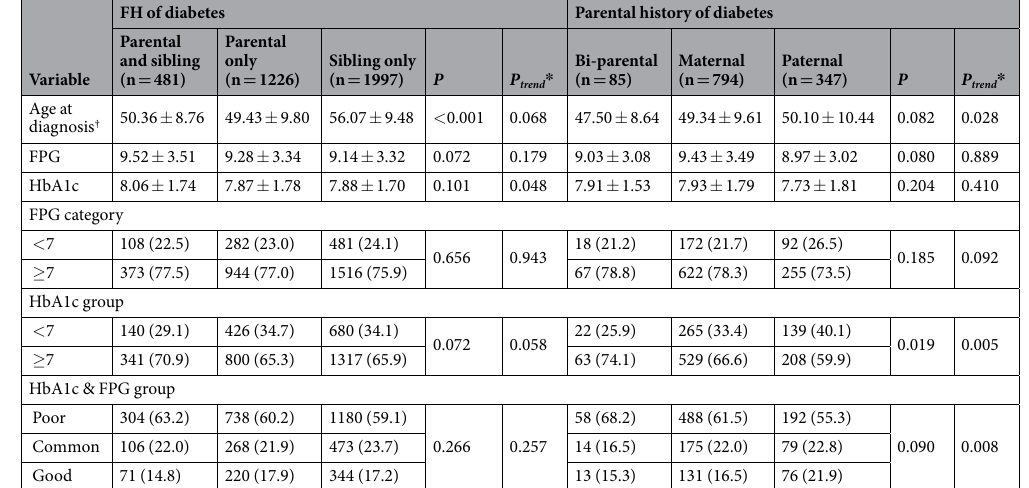
Table 2. Comparison of FPG, HbA1c and glycaemic control among type 2 diabetes patients with different FH of diabetes. Continuous variables were presented as the means (SD), and categorized variables as numbers (percentages). * P trend values were from linear trends for one-way analysis of variance and chi-squared test. † There were 8 missing values in the parental only group; 4 missing values in the sibling only group and 2 missing values in the maternal group.